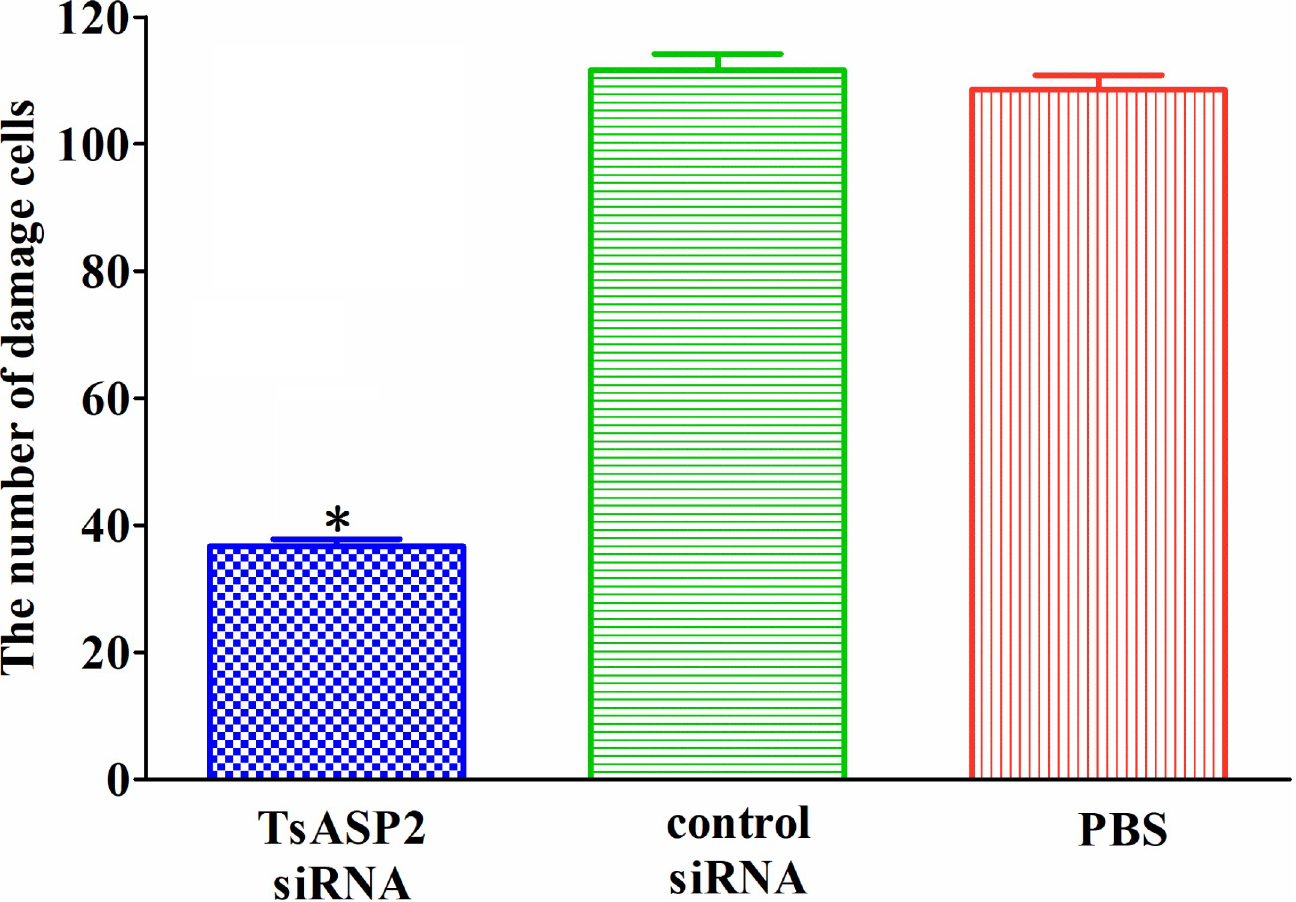
Fig 11. The number of damaged cells. The number of damaged cells caused by larvae treated with TsASP2 siRNA, control siRNA or PBS is expressed as the mean ± SD in an area of 3.02 mm 2 (10 × objective) for three monolayers. Asterisks indicate a statistically significant difference compared with the control siRNA and PBS groups ( � P <